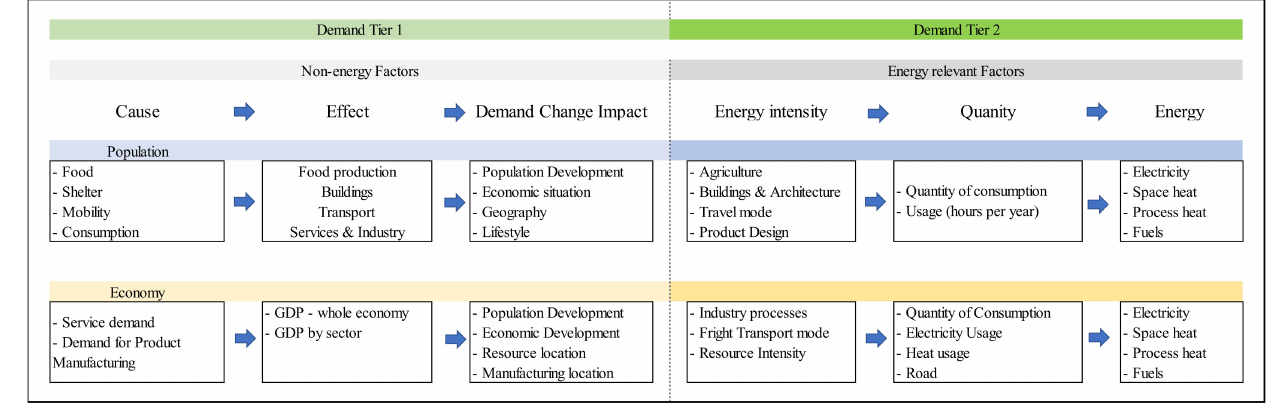
Figure 1. Tier 1 and tier 2 input parameters for the assessment of energy